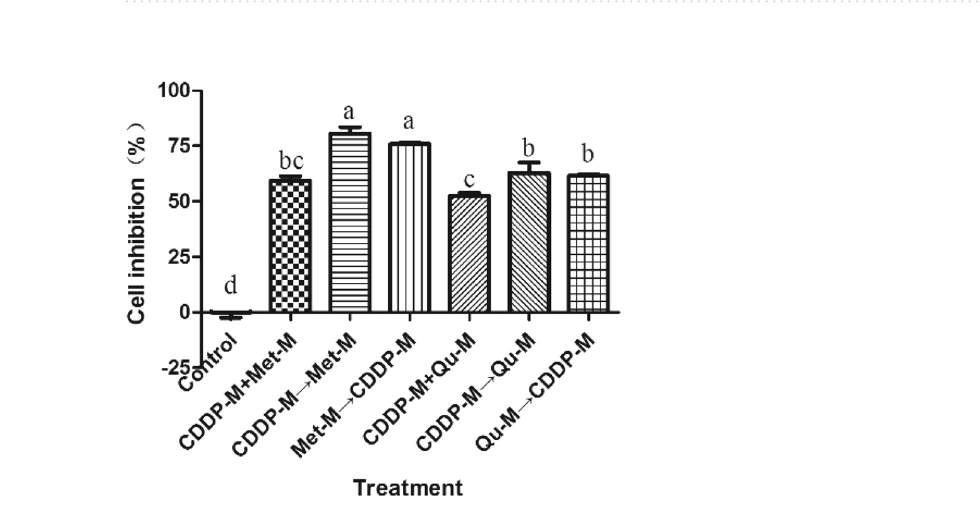
Figure 2. Effect of different combined application order of cisplatin and metformin, or quercetin on the proliferation of Sune-1 cells.